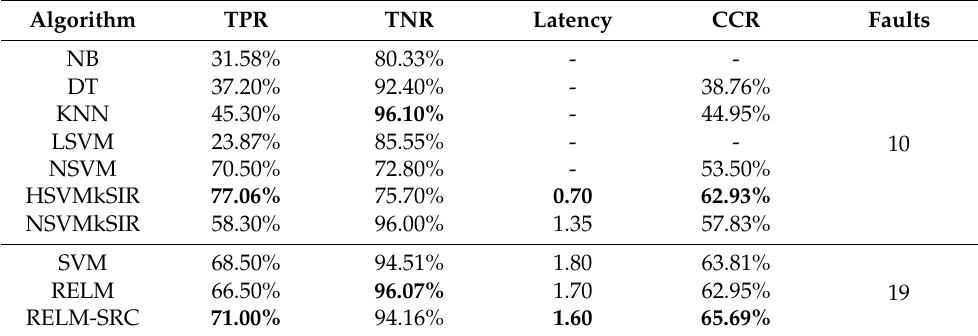
Table 8. Metrics for self-generated and ProDiMES testing datasets for abrupt faults (Stage 2, compari- son with [8,23]).